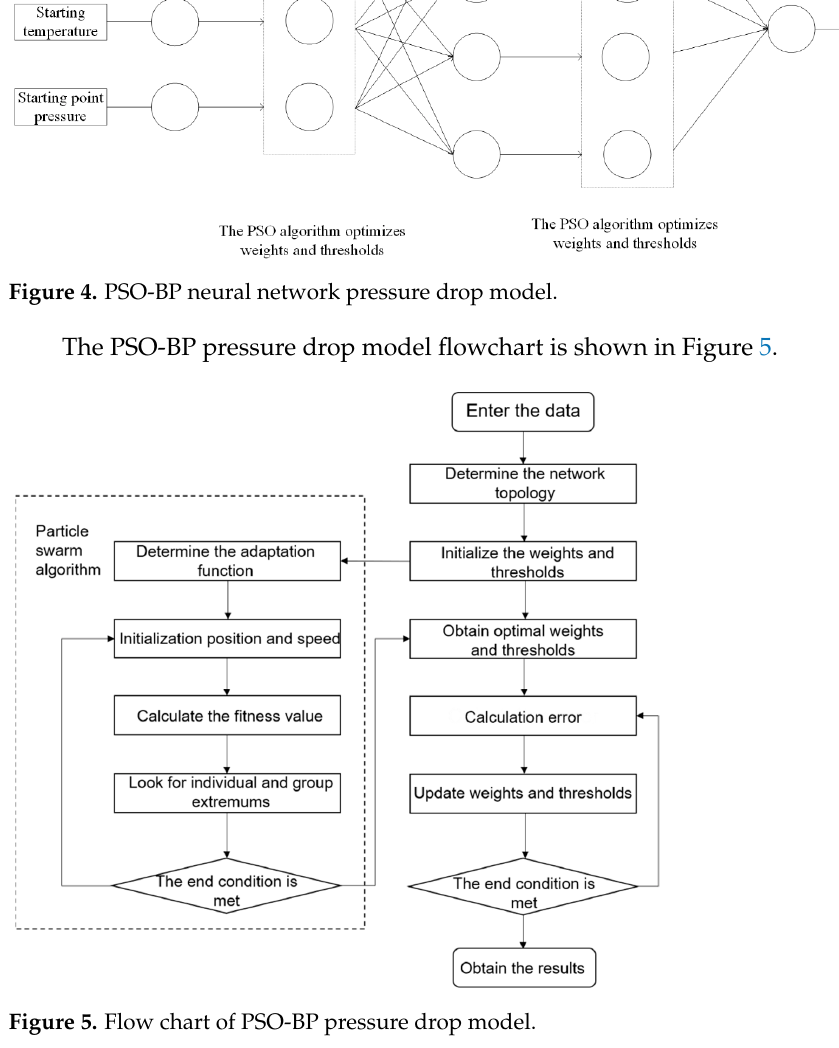
Table 1. Data table of the oil pipeline.